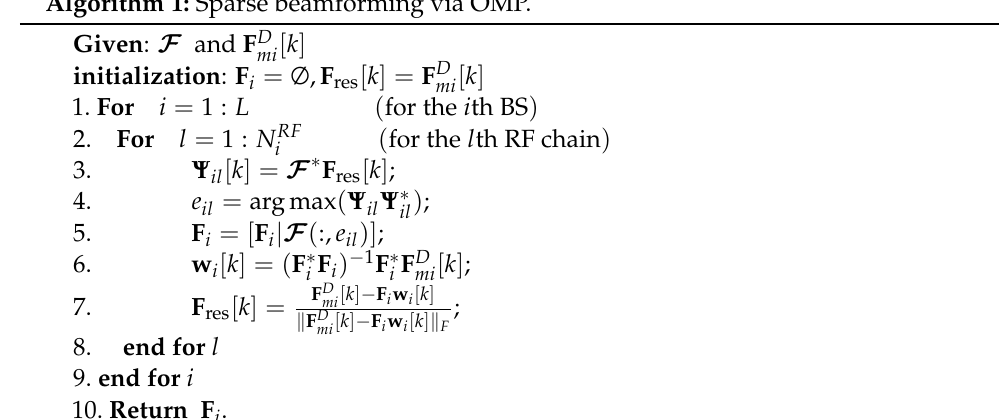
Algorithm 1: Sparse beamforming via